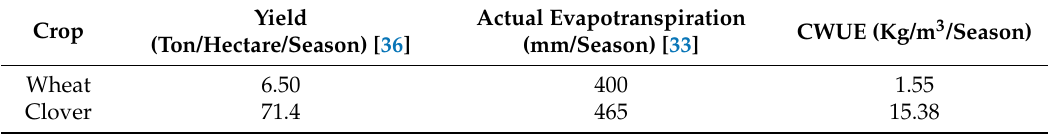
Table 5. Crop water use efficiency (CWUE) for the Al-Qased command area during the winter season (from November 2015 to May 2016). Yield Actual Evapotranspiration Crop (Ton/Hectare/Season) [36] (mm/Season) [33]